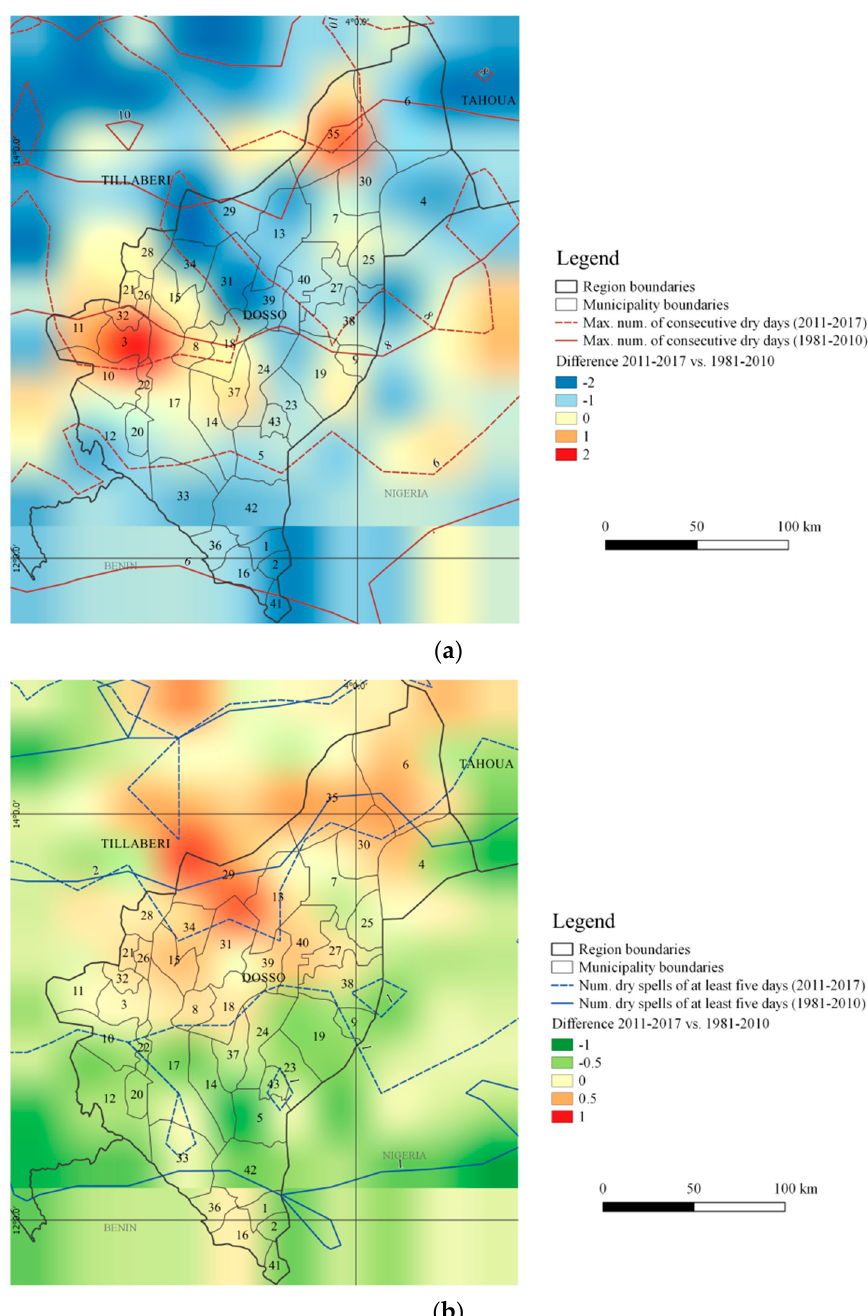
Figure 6. The difference in the maximum number of consecutive dry days between 2011–2017 and 1981–2010 ( a ); the difference in the number of spells of at least five dry days between 2011–2017 and 1981–2010 ( b ) (rainfall data from CHIRPS).